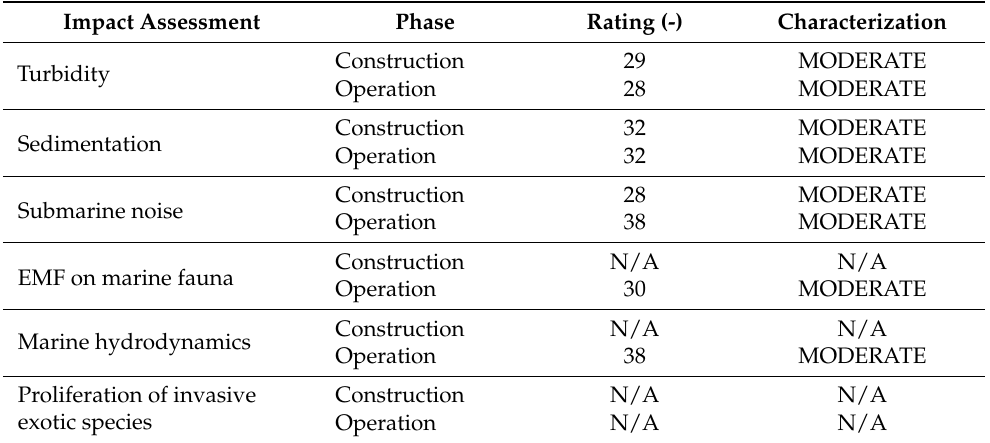
Table 9. Summary of analyzed environmental impact ratings and